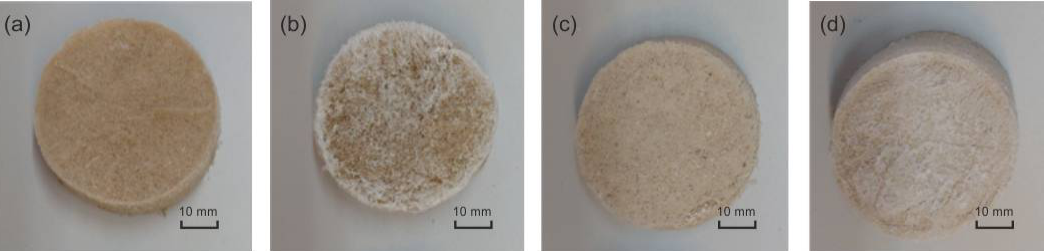
Figure 2. Photographs of aerogels with different cross-linking agents: ( a ) control samples (polyester resin), ( b ) cellulose acetate, ( c ) starch and ( d ) starch and cellulose acetate.